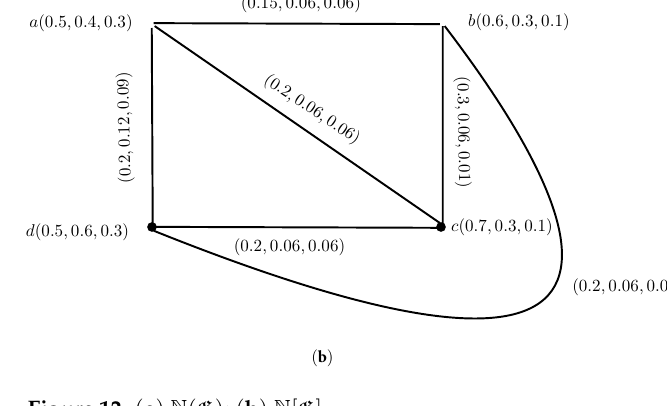
Figure 12. ( a ) N ( G ) ; ( b ) N [ G ]